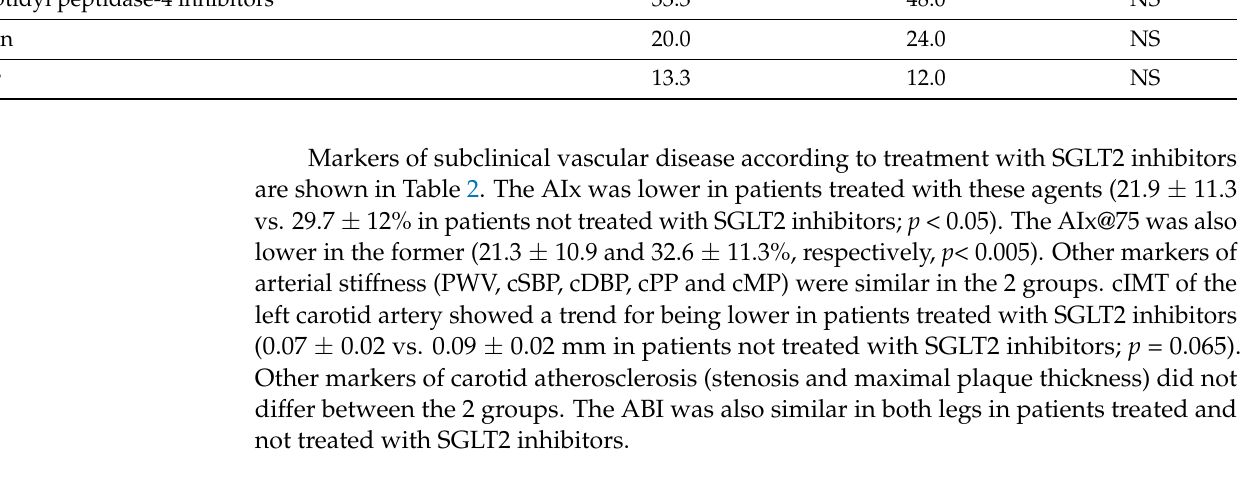
Table 2. Markers of subclinical vascular disease in patients treated and not treated with sodium- glucose co-transporter 2 (SGLT2) inhibitors (cases and controls,